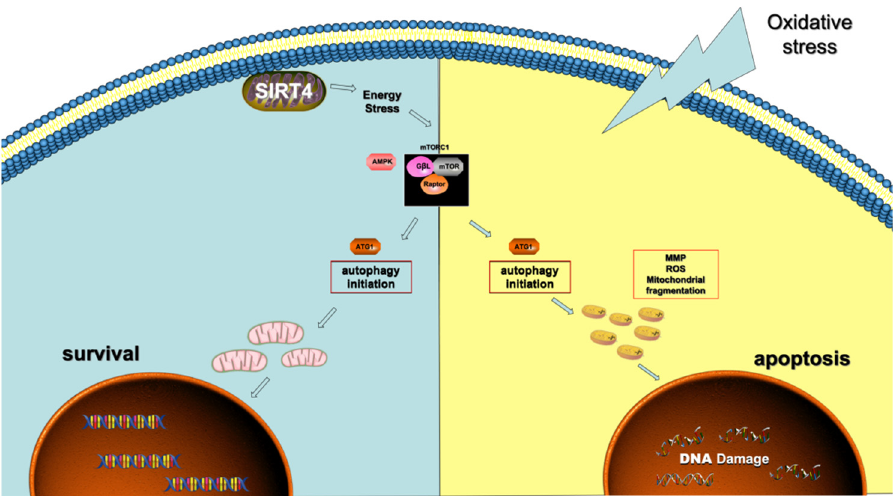
Figure 8. Schematic representation of the AMPK/mTOR signaling pathway regulated by SIRT4 in MGCs. Under normal conditions, SIRT4 depletion in MGCs inhibits ATP generation in mitochondria, which impinges on p-AMPK modulation, thus activating mTOR-mediated autophagy. Under oxida- tive stress, dysfunctional autophagy can induce disturbed mitochondrial dynamics by increasing mitochondrial fission and decreasing fusion, leading to MGC